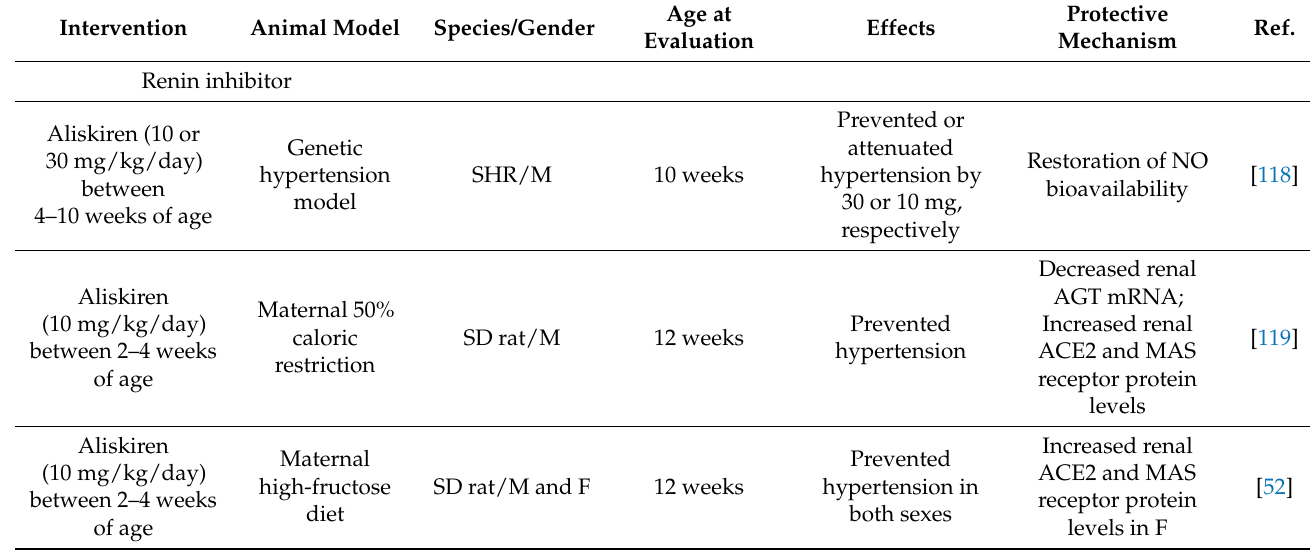
Table 2. Interventions targeting on the RAAS to prevent hypertension and kidney disease of developmental origins.Studies tabulated according to types of intervention, animal model, species, and age at evaluation. SD, Sprague Dawley; SHR, spontaneously hypertensive rat; M, male; F, female; ACE2, angiotensin-converting enzyme 2; AGT, angiotensinogen; Ang